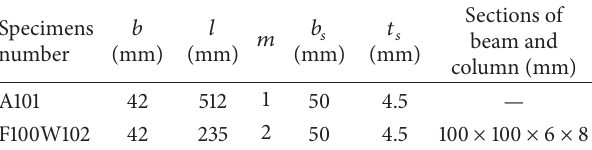
Table 3: Geometric parameters for